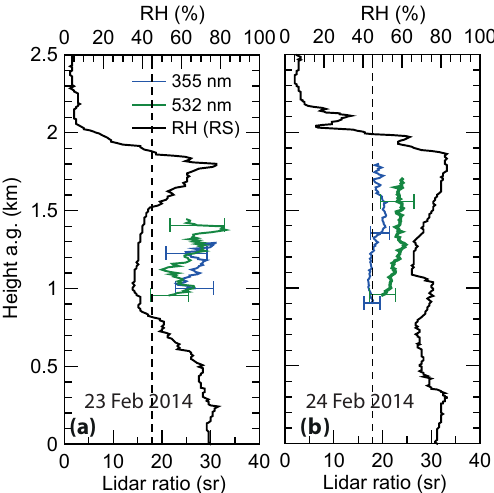
Figure 11. Two-hour mean profiles of the lidar ratio for the 23 February ( a 500m vertical smoothing) and the 24 February 2014 ( b 750m vertical smoothing): 532 (green line) without overlap cor- rection, full overlap at 800–1000m, and 355 (blue line) with overlap correction. The RH profile of the radiosonde (black line) indicates the different layers.